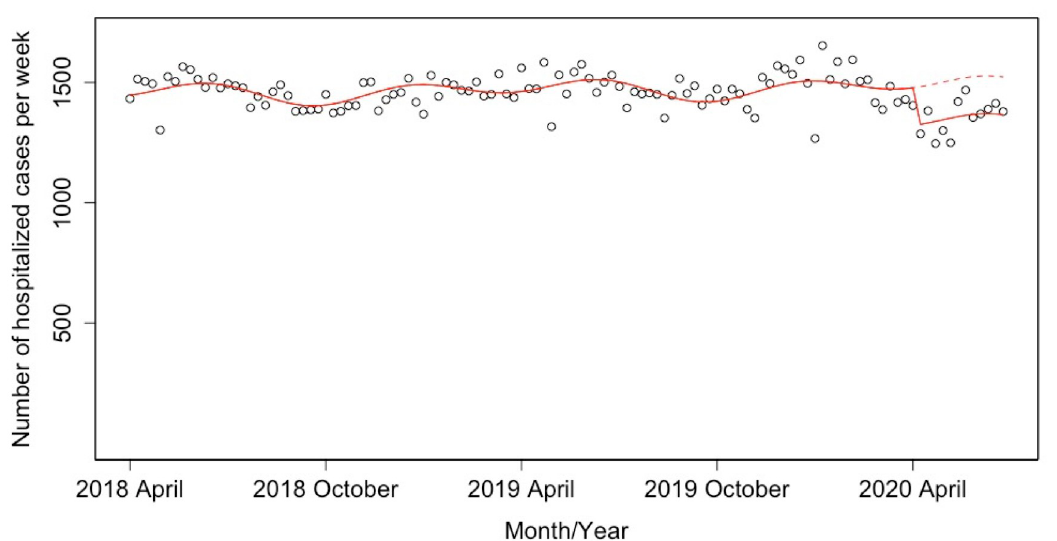
Fig 1. Result of the interrupted time series analysis for the weekly number of inpatients with ischemic stroke between April 1 2018 and June 27 2020. Solid lines indicate the predicted trend based on a model, and dashed lines indicate the predicted trend based on a model in the scenario without the state of emergency.